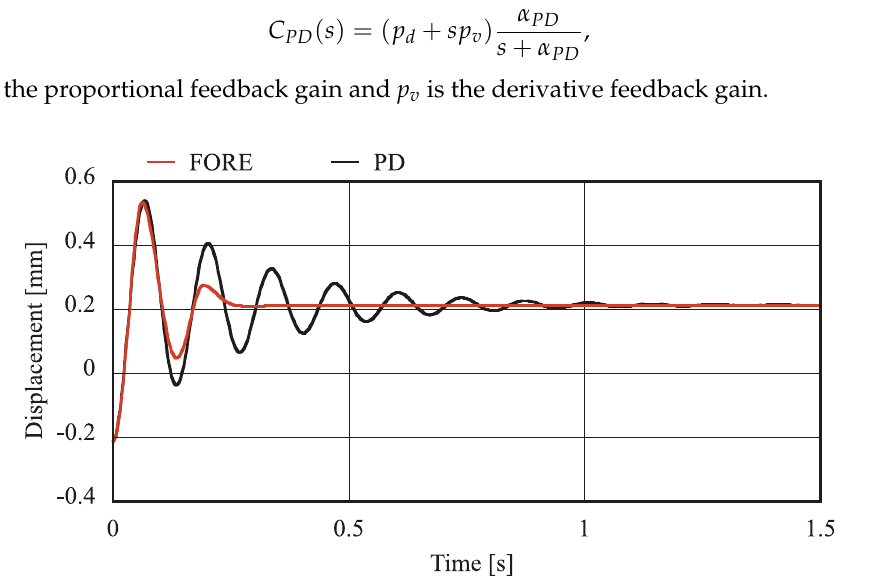
Figure 13. Comparison in time history between FORE- and proportional-derivative (PD)-controlled systems. FORE: red line; PD: black line.